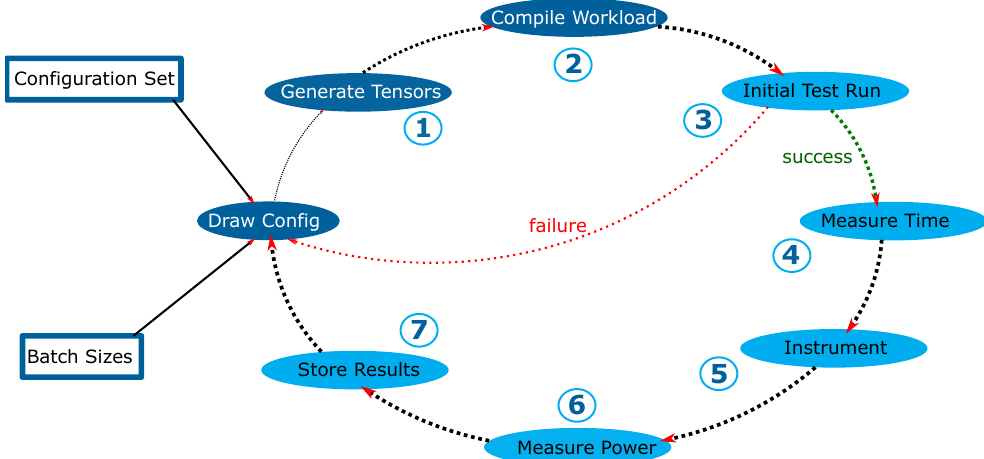
Figure 2. A visualization of the benchmarking and measurement flow: the boxes on the left are the datasets that are provided, containing the extracted workload configurations and batch sizes that will be profiled, dark blue bubbles marks operations that are performed on the offline device in case of the precompiled flow. Light blue bubbles will be executed on the target device itself in both flow